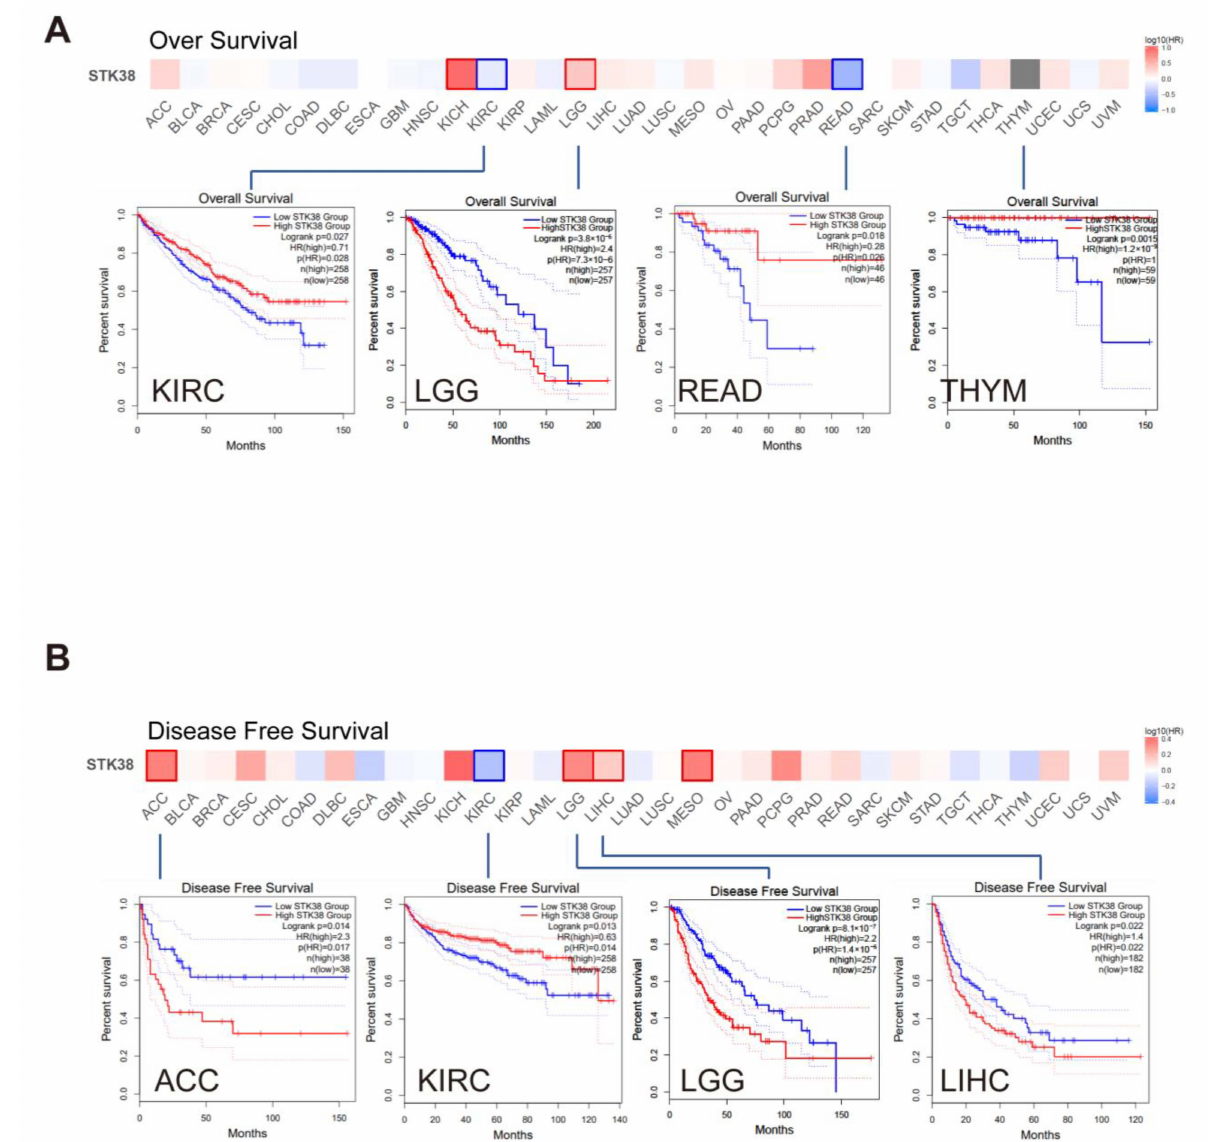
Figure 3. Correlation analysis between STK38 gene expression and prognosis of different tumors in TCGA. GEPIA2 tool was used to perform overall survival ( A ) and disease-free survival ( B ) analyses of TCGA tumors by STK38 gene expression. The survival map and Kaplan–Meier curves with positive results are listed. The red lines of Kaplan–Meier curves indicate the high STK38 expression groups, and the blue lines indicate the low STK38 expression